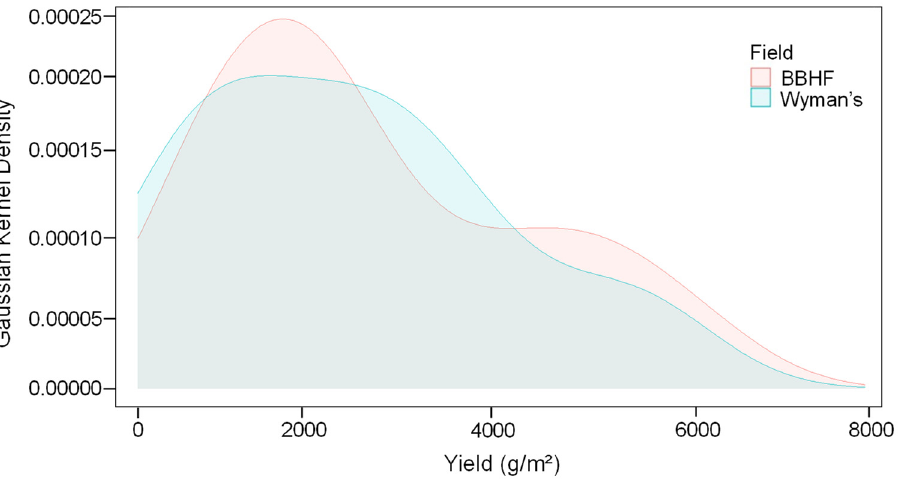
Figure 2. Gaussian kernel density estimates of the wild blueberry yield (g/m²) for the two studied wild blueberry fields, Wyman’s and BBHF. Table 2. Comparison between Jasper Wyman & Son Blueberry Farm (Wyman’s) and from Blueberry Hill Farm (BBHF) blueberry fields in yield-related, morphological, and functional traits in the min- imum (Min), maximum (Max), mean, and standard deviation (SD) of Yield, WT, NBS, LBC, StemN, StemL, StemD, LCC, LMA, LAPS, LNPS, NBPS, LeafT, SoilT, and SWC. To determine trait differ- ences between the two fields and genotypes within fields, we used a hierarchical nested mixed model with field as the fixed effect and genotype nested with-in field as the random effect. LeafT, SoilT, and SWC data were only available for the Wyman’s field. For definitions of trait abbrevia- tions, please see Table 1.